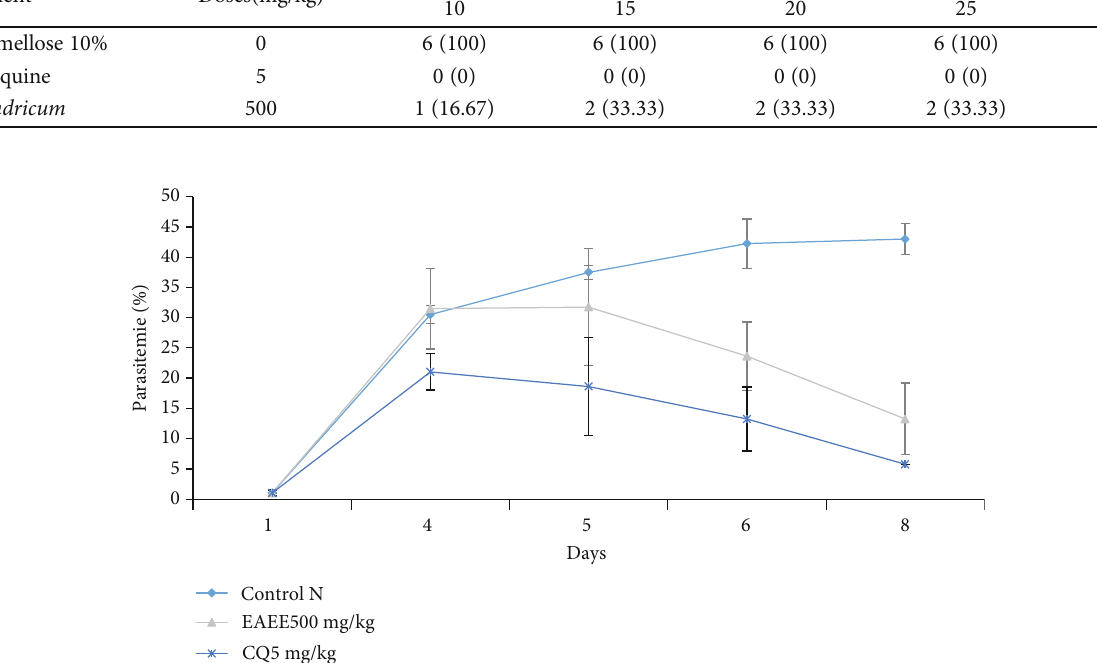
Table 3: Cumulative number (n) and mortality rate (%) of the experimental animals after treatment. Treatment